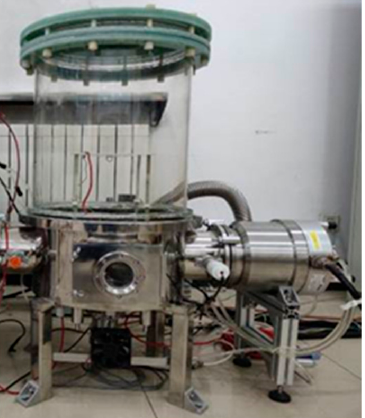
Figure 1. Physical graph of vacuum tank.